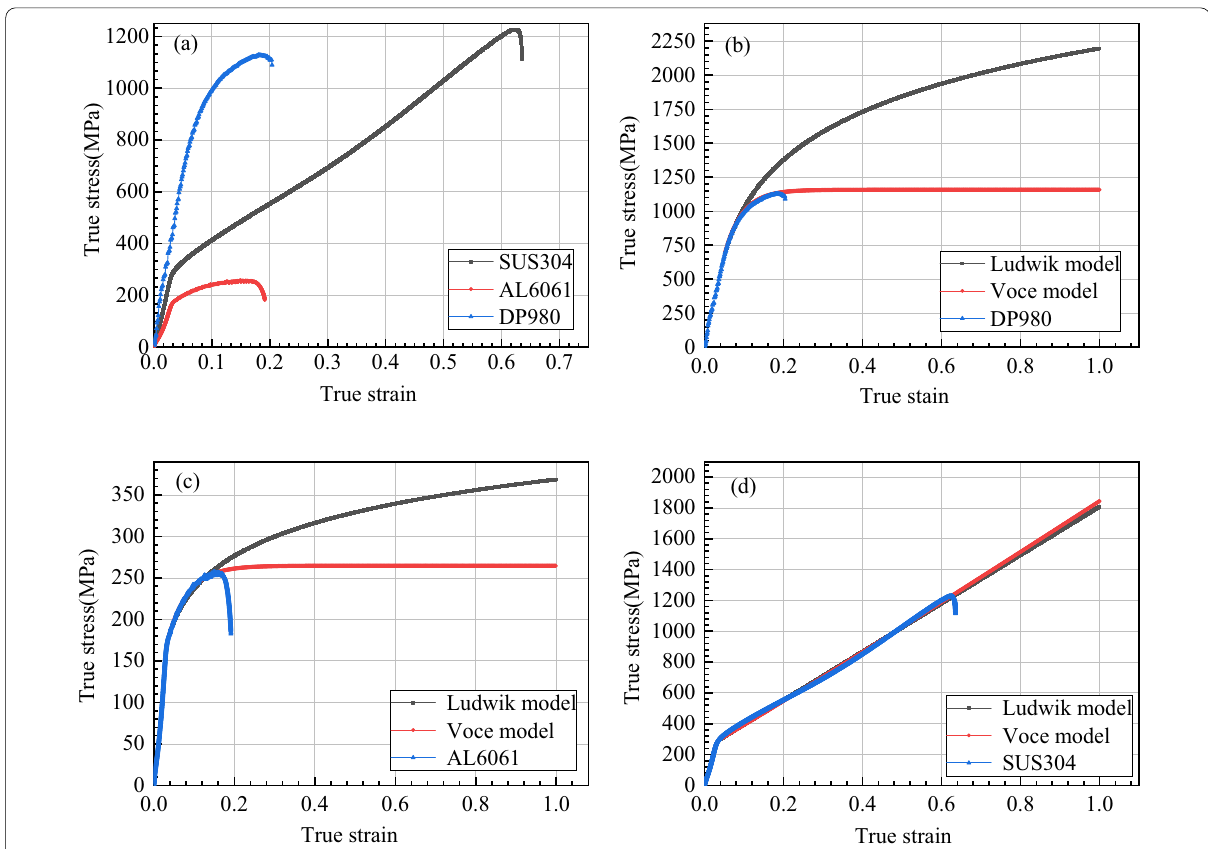
Figure 1 a Stress-strain curve, b DP980 stress-strain curve and the curves fitted by Ludwik and Voce model, c AL6061 stress-strain curve and the curves fitted by Ludwik and Voce model; d SUS304 stress-strain curve and the curves fitted by Ludwik and Voce